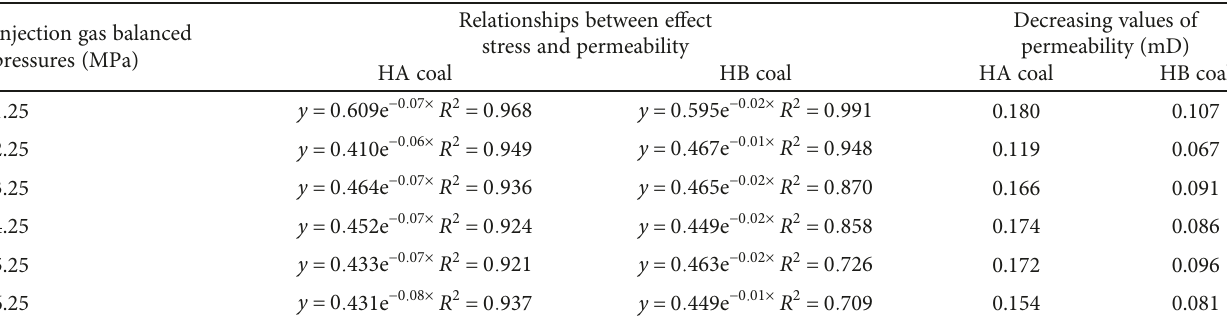
Relationships between e ff ect stress and permeability